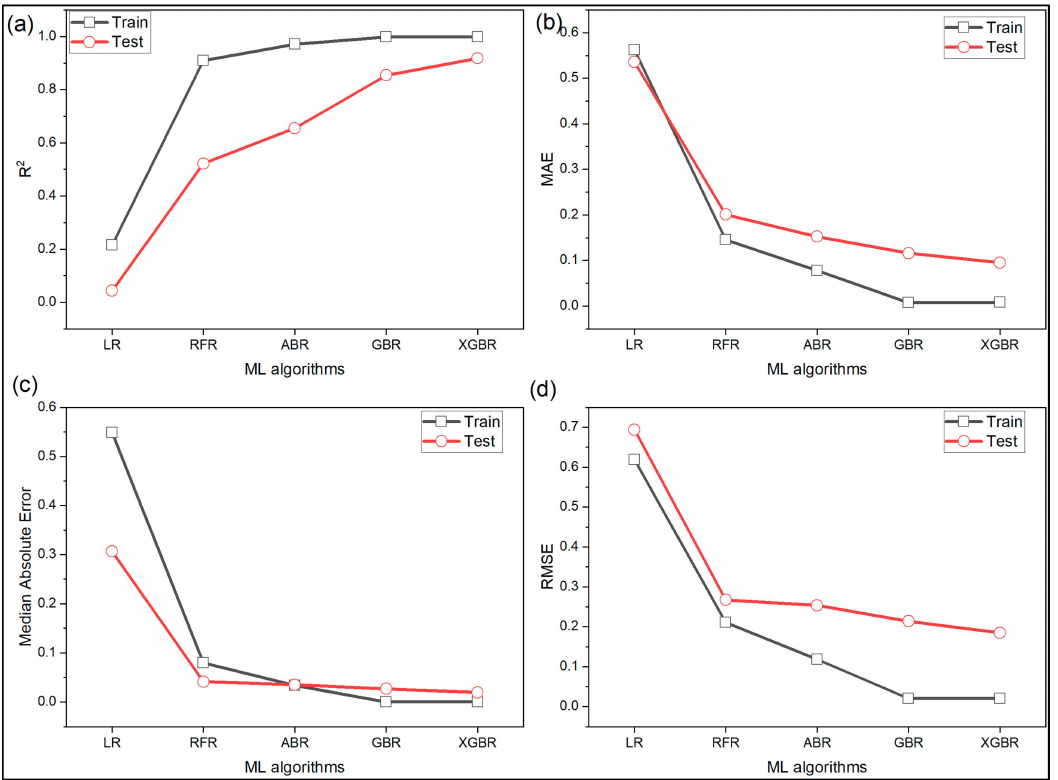
Figure 8. Performance of various ML algorithms measured using ( a ) R 2 ; ( b ) mean absolute error; ( c ) median absolute error; ( d ) root mean squared error for case study